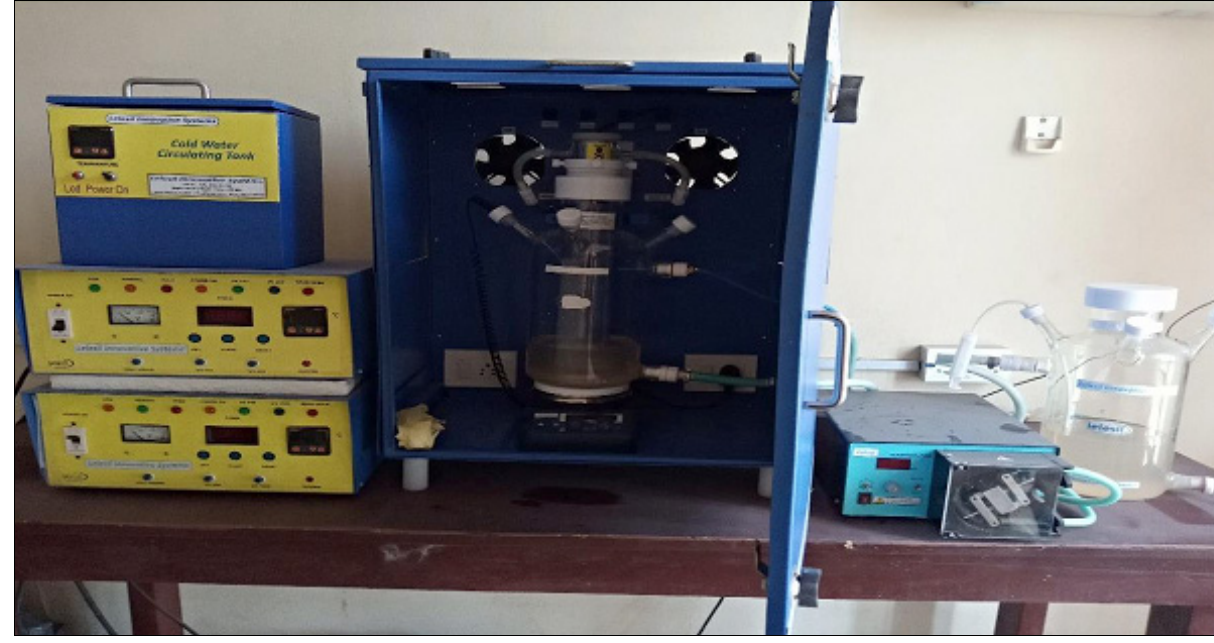
Figure 1: Set-up of the flow-through twin photocatalytic reactors system. Table 1: Physicochemical characteristics of the raw and treated edible oil refinery wastewater